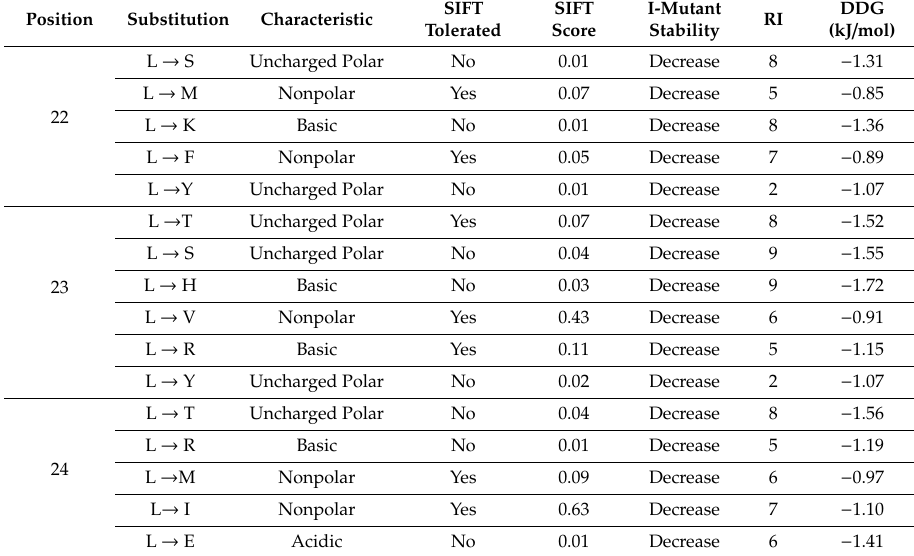
Table 1. Mutation Analysis of tetherin in I-Mutant 3.0 and Sorting Intolerant From Tolerant (SIFT). RI = reliability